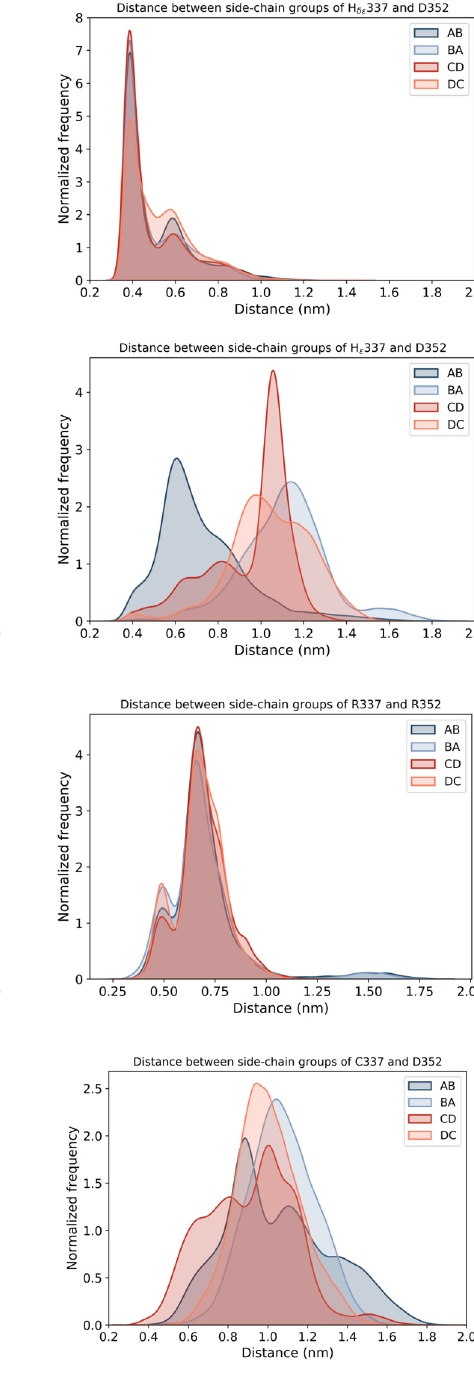
Figure 3. Analysis of the distances between side chains of residues 337 and 352 within the p53 tetramer. The interchain distance between residues involved in the salt-bridge formation at positions 337 and 352 in the WT protein was analyzed for all of the simulated systems. The graphs display the measure of the distance between the centers of mass of the functional groups of each couple of amino acids (337 and 352), initially forming salt-bridges between two pairs of the four polypeptide chains of the tetramer (A with B and C with D), resulting in the 4 different arrangements (i.e., 337.A-352.B, 337.B-352.A, 337.C-352.D, and 337.D-352.C). The results show that only the charged histidine at position 337, the double-mutant R337D/D352R, and the D352R mutant displayed distance distributions compatible with the formation of effective interactions.